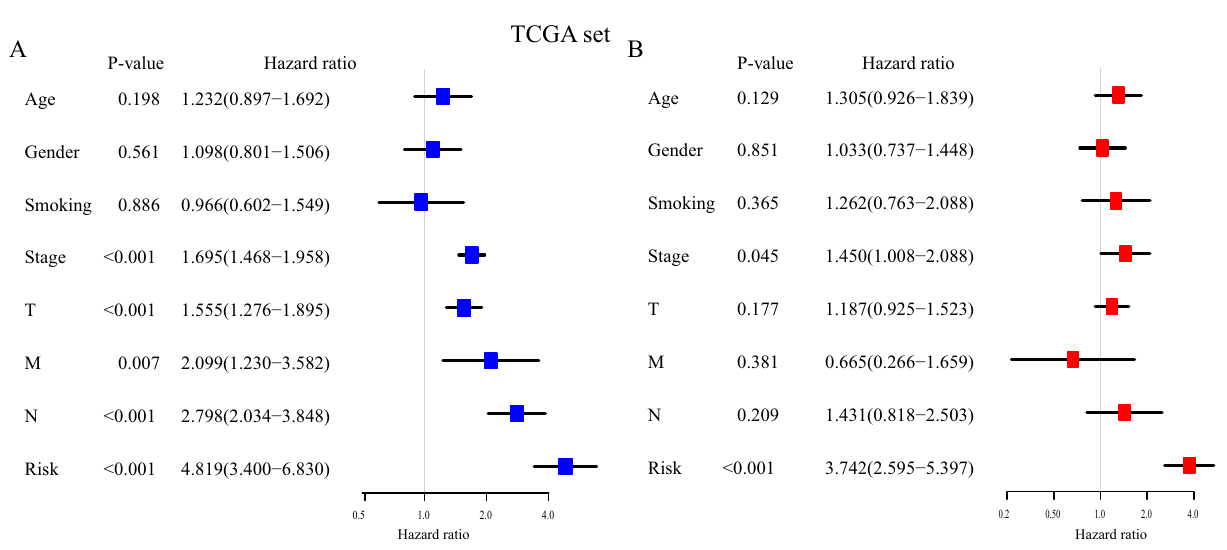
Figure 4. Stratification analyses of overall survival between high- and low-risk patients in different subgroup. ( A ) Age ≤ 65. ( B ) Age > 65. ( C ) Female. ( D ) Male. ( E ) TNM grade I. ( F ) TNM grade II. ( G ) TNM grade III. ( H ) TNM grade IV. ( I ) T1. ( J ) T2. ( K ) T3. ( L ) T4. ( M ) Without lymph node metastasis. ( N ) With lymph node metastasis. ( O ) Without distance metastasis. ( P ) With distance metastasis.